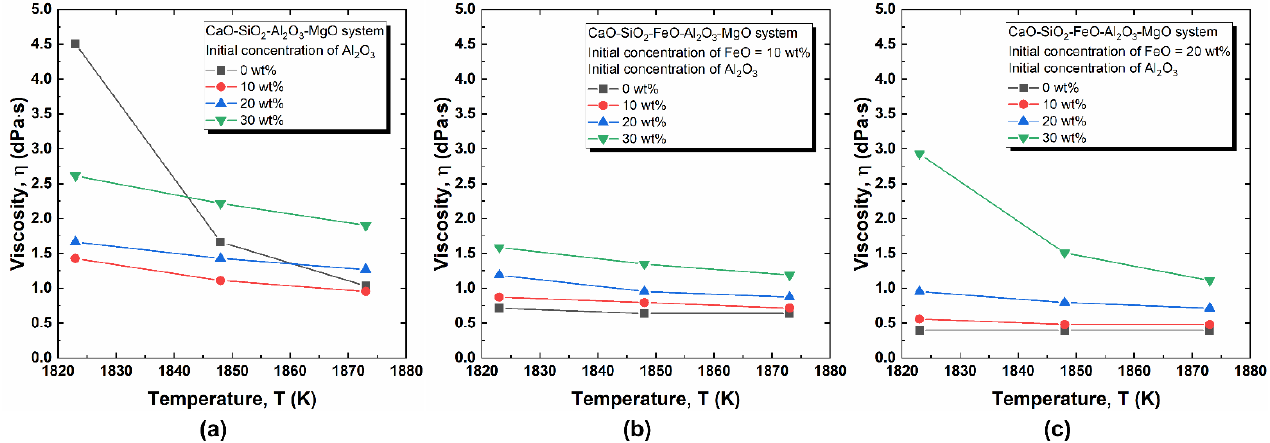
Figure 2. Relationship between viscosity and temperature in the ( a ) CaO–SiO 2 –Al 2 O 3 –MgO system, ( b ) CaO–SiO 2 –FeO– Al 2 O 3 –MgO system with 10 wt% FeO, and ( c ) CaO–SiO 2 –FeO–Al 2 O 3 –MgO system with 20 wt% FeO.